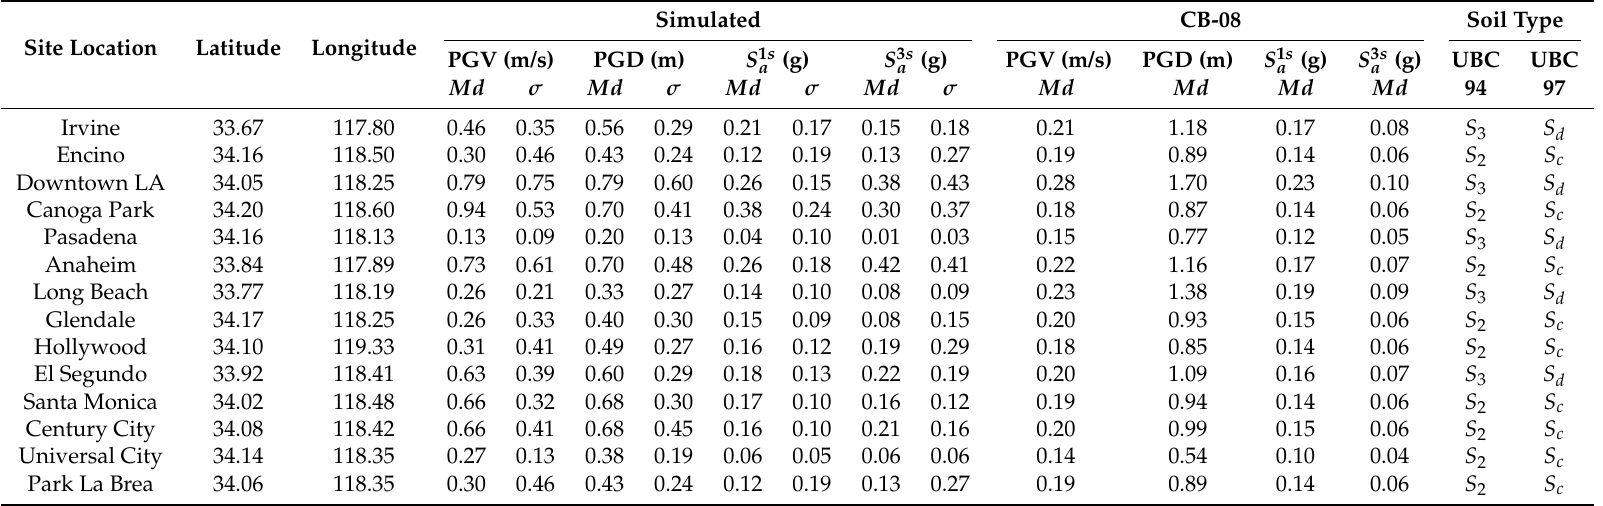
Table 3. Comparison of ground motion intensities from the ten (five locations and two rupture directions) simulated M w 7.89 scenario earthquakes against CB-08 NGA predictions at fourteen locations in southern California where a significant number of tall buildings